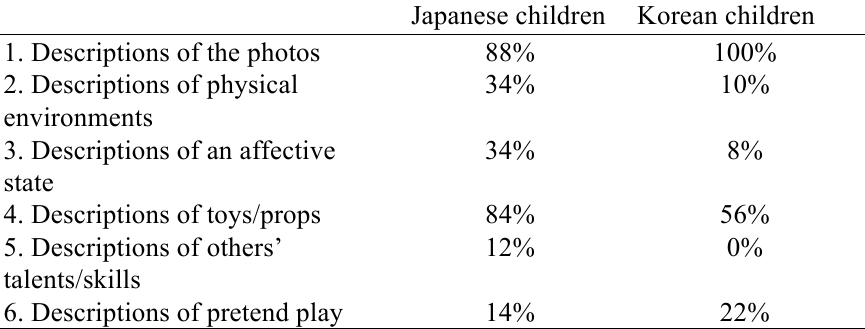
Children’s reasons for taking